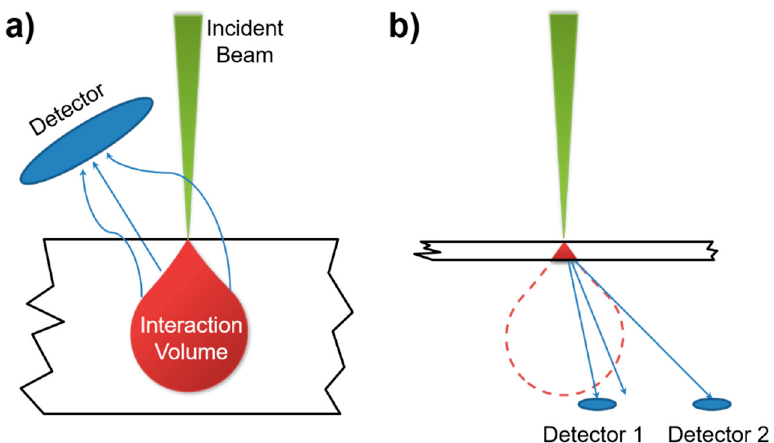
Figure 4. Interaction volume in a thick sample ( a ) and a thin sample ( b ), showing also the idea of selective detection.